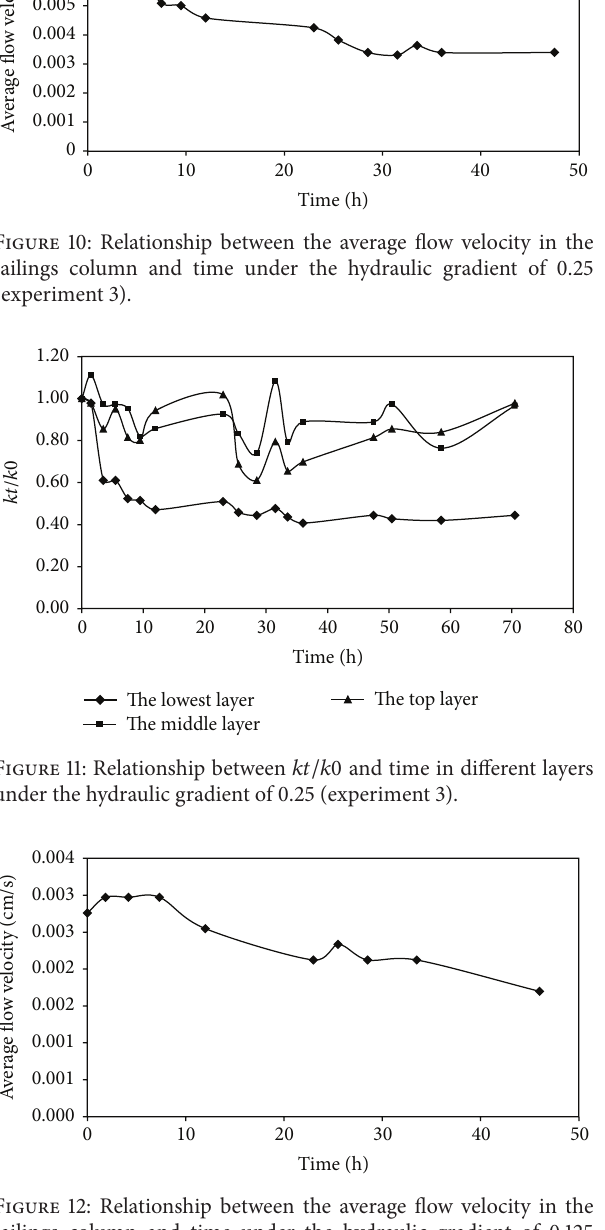
Figure 12: Relationship between the average flow velocity in the tailings column and time under the hydraulic gradient of 0.125 (experiment 4).